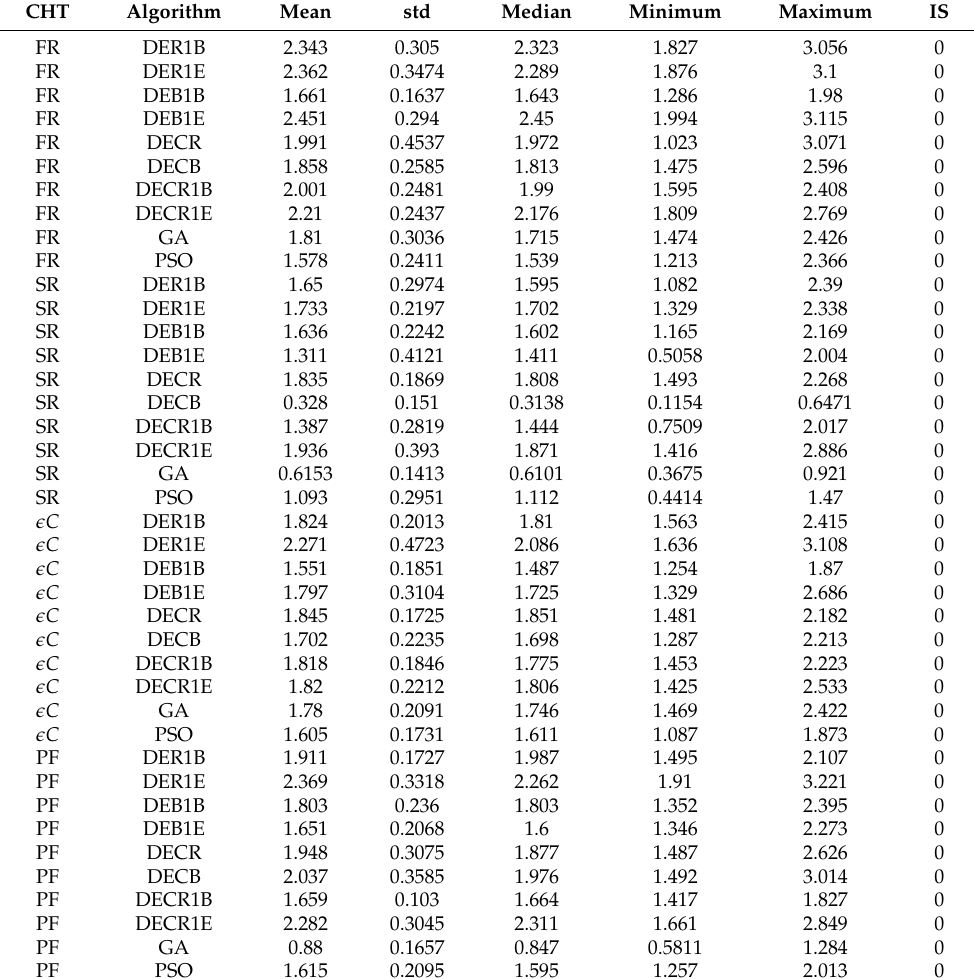
Table A21. PR descriptive statistics for study case 1: Four-bar linkage mechanism. IS means the number of infeasible solutions through the